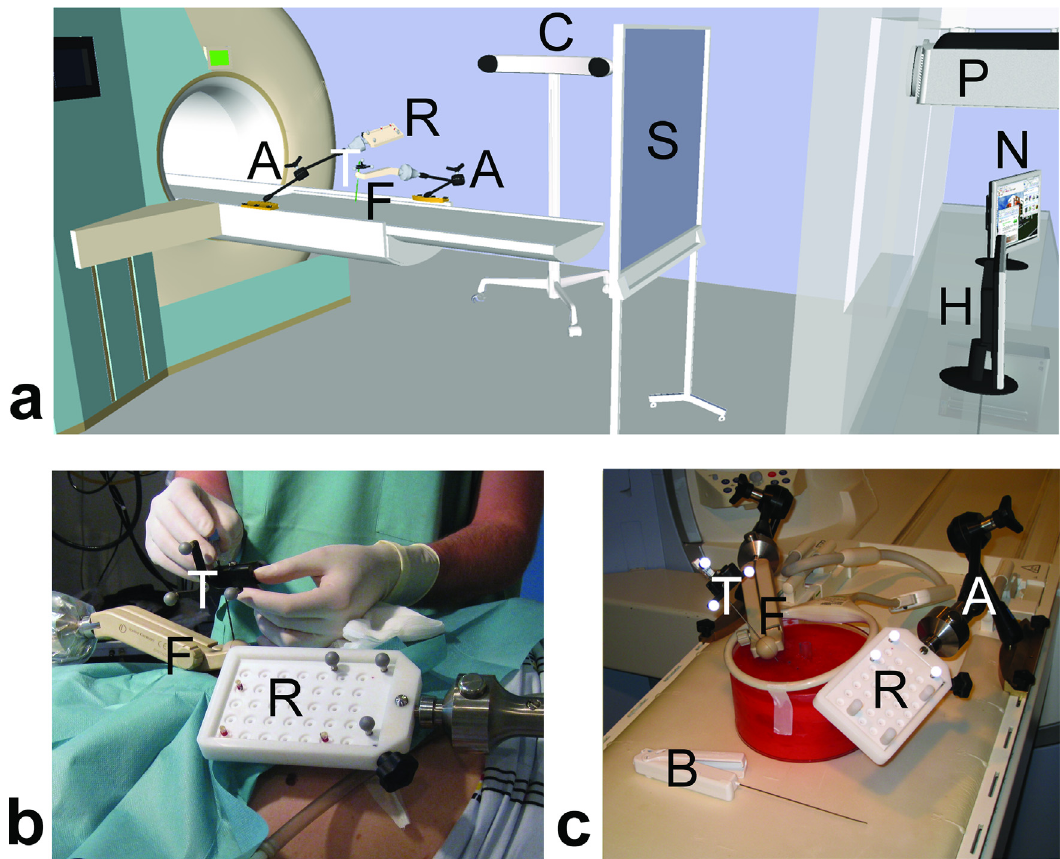
Fig 1. Add-on navigation solution for MRI-guided interventions. (a) Schematic drawing of the overall setup illustrating the components at the MRI table ("A" articulating arm, " R" reference board, "F" front-end module for alignment; "T" tracker for instrument), in the MR room ("C" optical 3D tracking camera, "S" projection screen) and in the control room ("P" LCD projector, "N" navigation workstation, "H" MR host computer). (b) Clinical setup of an MRI-navigated biopsy in the kidney. (c) Experimental setup used for the assessment of targeting accuracy, procedure times and usability ("B" biopsy gun).